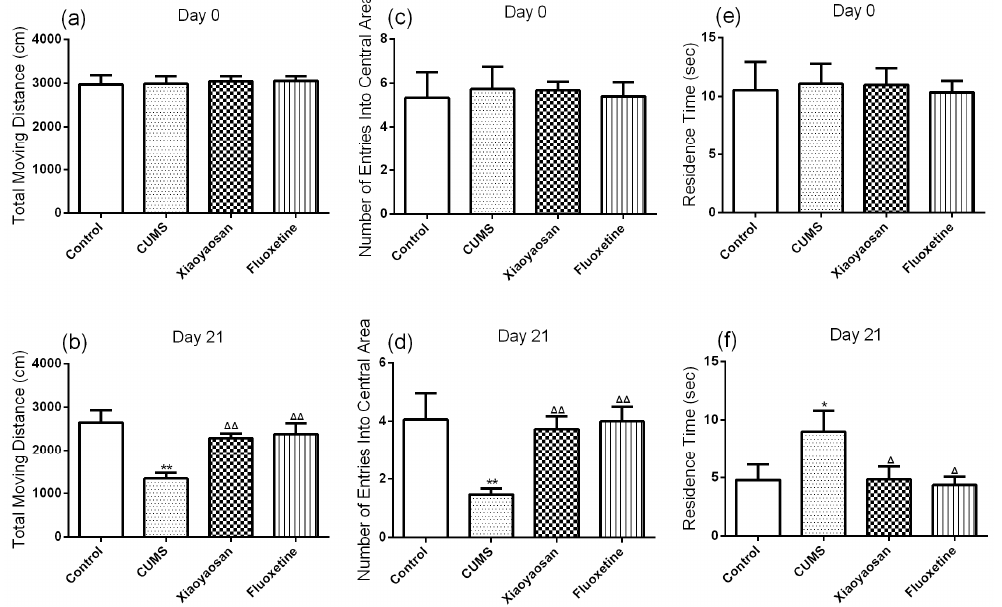
Figure 3. ( a ) The total moving distance of mice in each group at day 0 (baseline); ( b ) The total moving distance of mice in each group at day 21; ( c ) The number of entries into central area of mice in each group at day 0 (baseline); ( d ) The number of entries into central area of mice in each group at day 21; ( e ) The residence time of mice in each group at day 0 (baseline); ( f ) The residence time of mice in each group at day 21. Data were expressed as means ± SEM ( n = 15), * p < 0.05, ** p < 0.01 versus control group; Δ p < 0.05, ΔΔ p < 0.01 versus CUMS group.